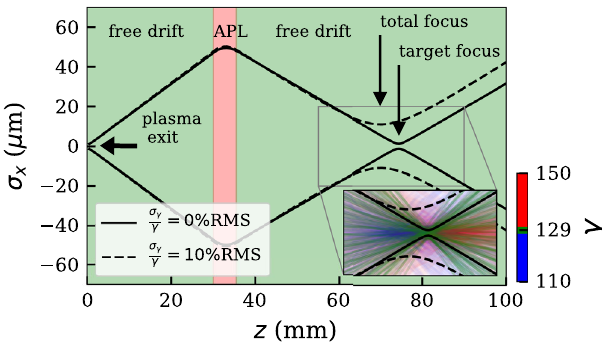
FIG. 3. The simulation results of the Thomson spectra are shown in terms of the bandwidth BW θ (a) and effective photon production μ (b) for interaction at the plasma exit for different eff distances (blue, dashed blue and cyan) and after APL focusing in the target and total focus (red and orange). (c) x-ray spectra obtained from a 10% RMS energy spread bunch without (blue) and with APL focusing (red,